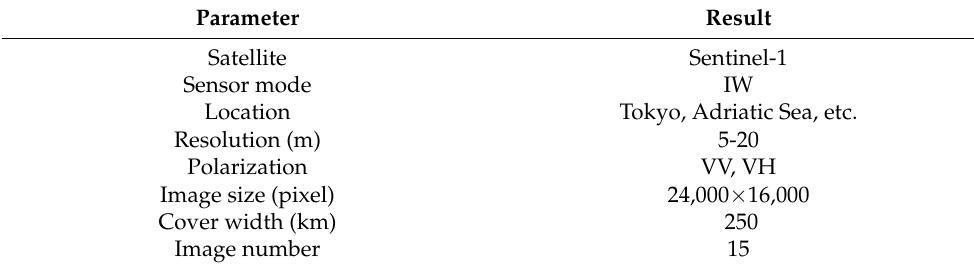
Table 3. Details of the LS-SSDD-v1.0.